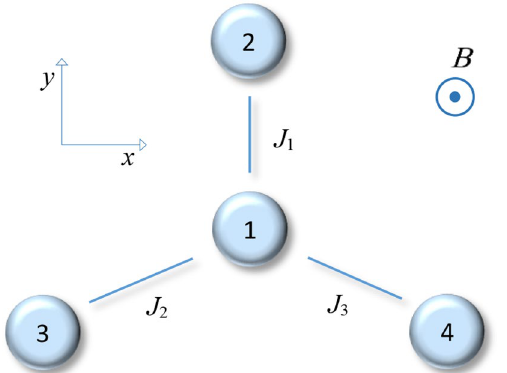
Figure 1. A schematic diagram of a four-qubit spin-star system. The qubits labelled 2–4 are coupled to the central one with J 1 , J 2 , and J 3 which are the coupling constants, respectively. The external magnetic field B is perpendicular to the plane where the four qubits